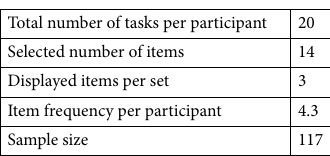
Table 2. Sample-size